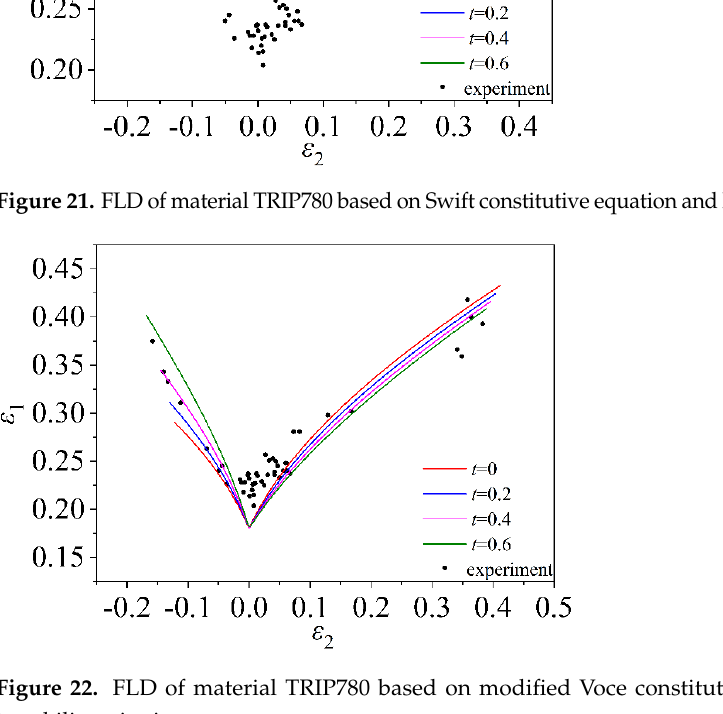
Figure 21. FLD of material TRIP780 based on Swift constitutive equation and MMFC instability cri- terion.